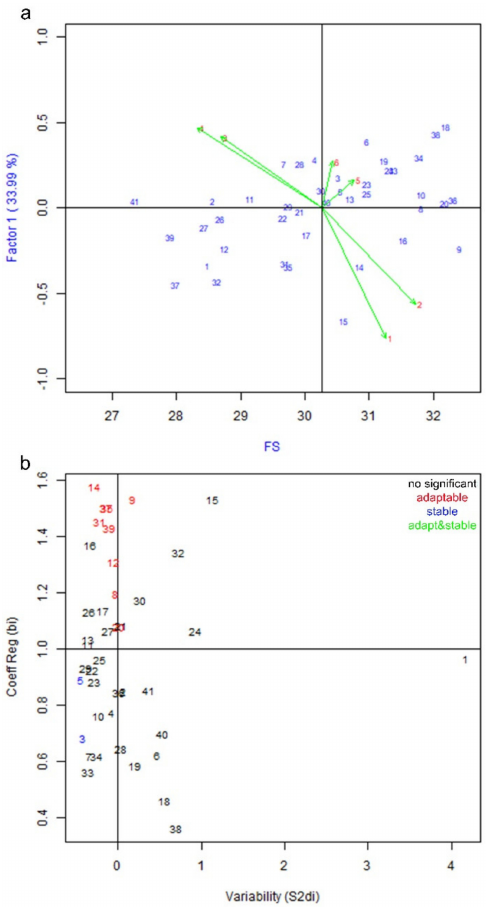
Figure 5. Mean performance and stability of 41 genotypes in six environments for fiber strength (FS). ( a ) Represents the mean of FS (cN / tex) on the X-axis and first interaction principal component (IPC1) scores of GEI on the Y-axis. Blue and red colored numbers inside the biplot show genotypes and environments, respectively. ( b ) Shows stability analysis of FS, coe ffi cient of variability (X-axis) and coe ffi cient of regression (Y-axis). All numbers inside the biplot show genotypes. See Tables 1 and 2 for code description of genotypes and environments,